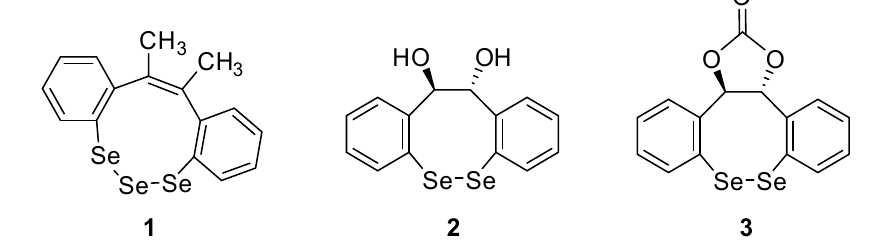
Figure 1. Examples of cyclic di- and triselenides [1,2].